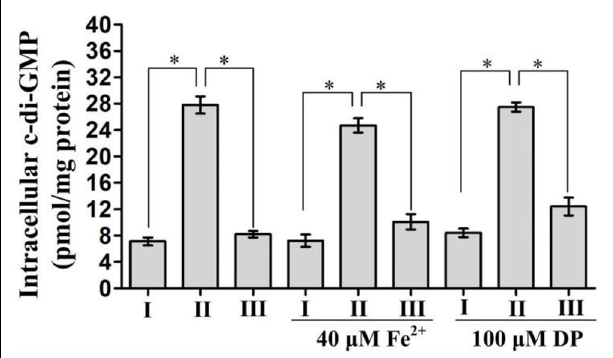
FIGURE 2 | Intracellular c-di-GMP concentrations in Vibrio cholerae strains. Bacterial cells were cultured in Luria-Bertani (LB) broth, LB supplemented with 100 µ M 2 (cid:48) -dipyridyl (DP), and LB supplemented with 40 µ M FeSO 4 at 30 ◦ C. Intracellular c-di-GMP concentrations were analyzed in bacteria grown to an OD 600 = 0.6 ∼ 0.8. The data are expressed as the mean ± SD of at least three independent experiments. I, II, and III represent WT/pBAD24, (cid:49) fur /pBAD24, and (cid:49) fur /pBAD24- fur , respectively. The symbol ∗ represents the significant difference with P < 0.01.